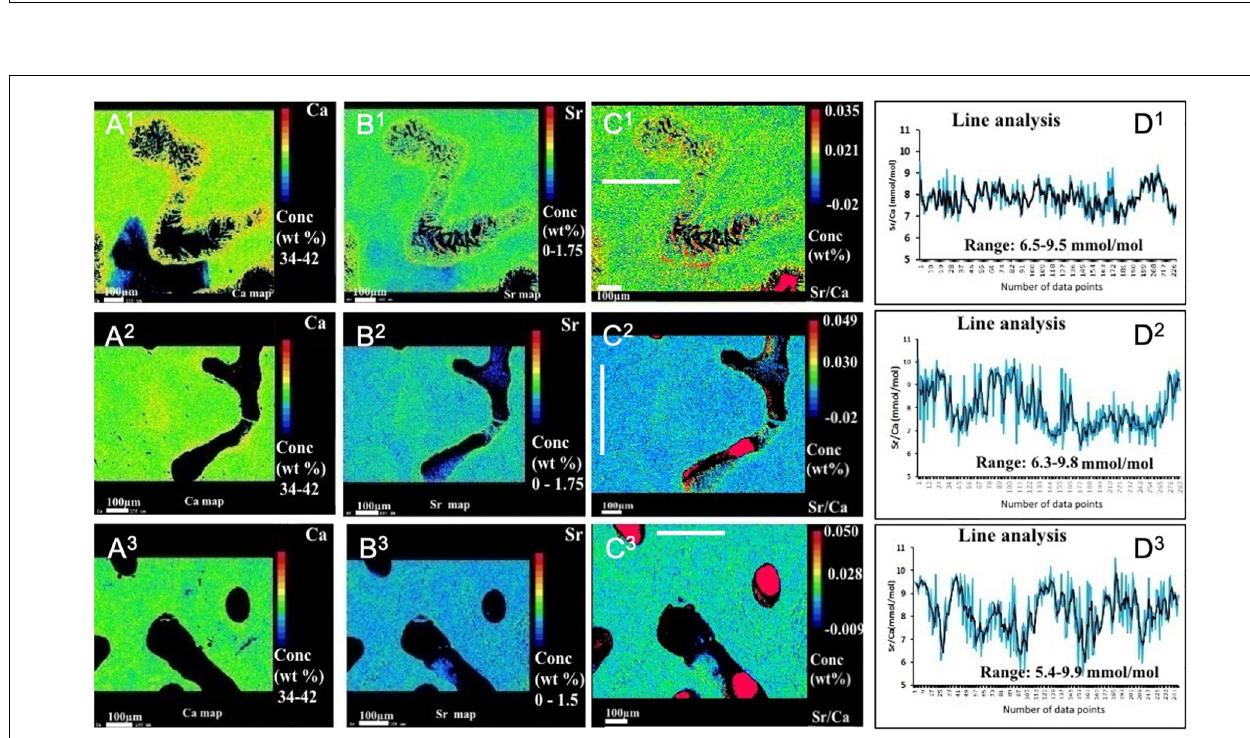
FIGURE 5 | Electron microprobe (EMP) Sr and Ca concentration distribution maps in the studied coral samples. Panels (A 1 –D 1 ) show the Ca, Sr, Sr/Ca, and Sr/Ca line analysis in the sample H-Tai-2, panels (A 2 –D 2 ) in HM4, and (A 3 –D 3 ) in WL1 sample. Note the shift towards higher elemental concentrations at the rims and within the aragonite needles in diagenetically altered samples. Positions of the line analyses are indicated within the EMP maps as white lines, with results presented in the right panels (D) . Here, blue lines indicate single values and black lines the three-point running mean. Sr/Ca ratios from line analyses were obtained by dividing measured Sr content by Ca in the same cell along a line after calibration. Elemental content is given in weight percent in the EMP maps and in mmol/mol for Sr/Ca in the line analysis plots.